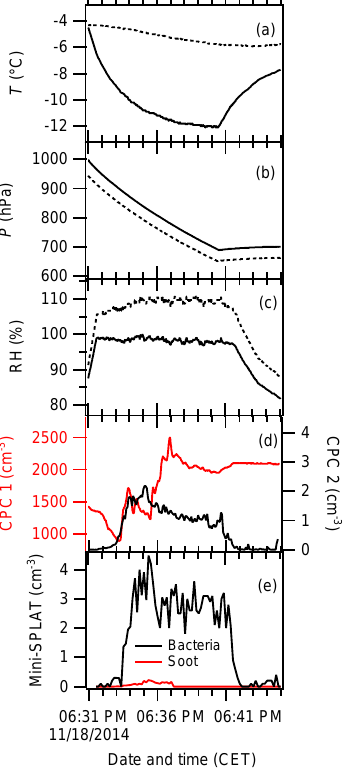
Figure 14. Temporal plots of the AIDA expansion experiments from FIN01_38. Panels are arranged to show the chamber gas T (solid line) and the IS-PCVI nozzle T (dotted line) (a) , P in the AIDA chamber (solid line) and the IS-PCVI (dotted line) (b) , RH with respect to water (solid line) and ice (dotted line) (c) , CPC counts (left axis = total particle counts from the CPC 1; right axis = residual counts from the CPC 2) (d) , and miniSPLAT- measured composition-resolved particle concentration in cm − 3 (e) . RHs were determined with an accuracy of ± 5%. The residual counts measured by CPC 2 are corrected according to Eq. (6), while no enhancement factor correction is included for miniSPLAT con-